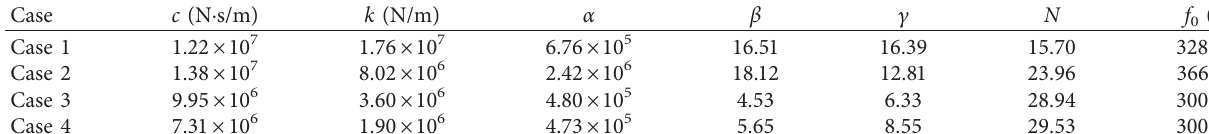
Table 8: Identification results for the MR damper experiment.